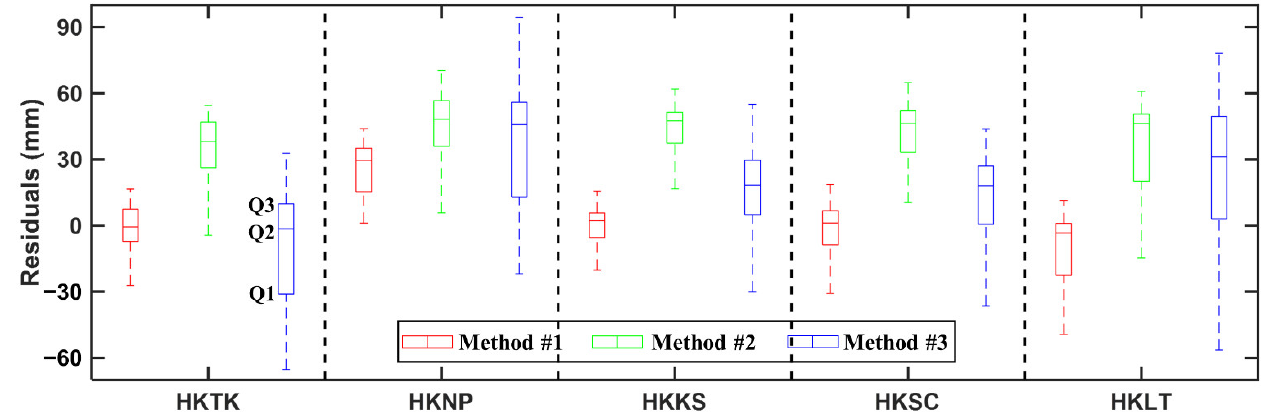
Figure 8. Box and Whisker of the residuals for the three methods.